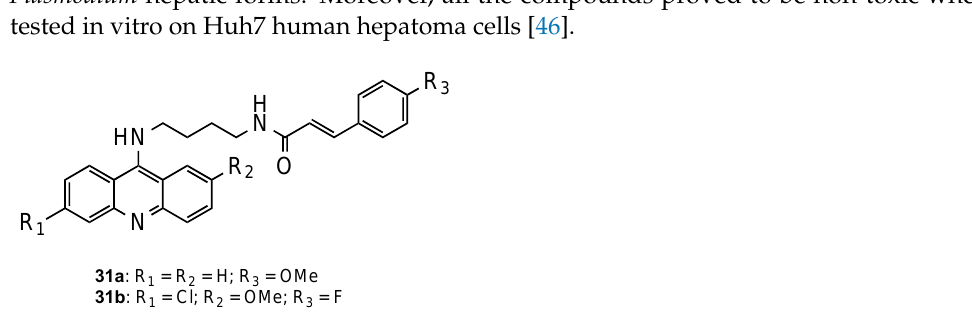
Figure 20. Acridine – cinnamic acid conjugates 31 development by Gomes and co-workers [46,47].